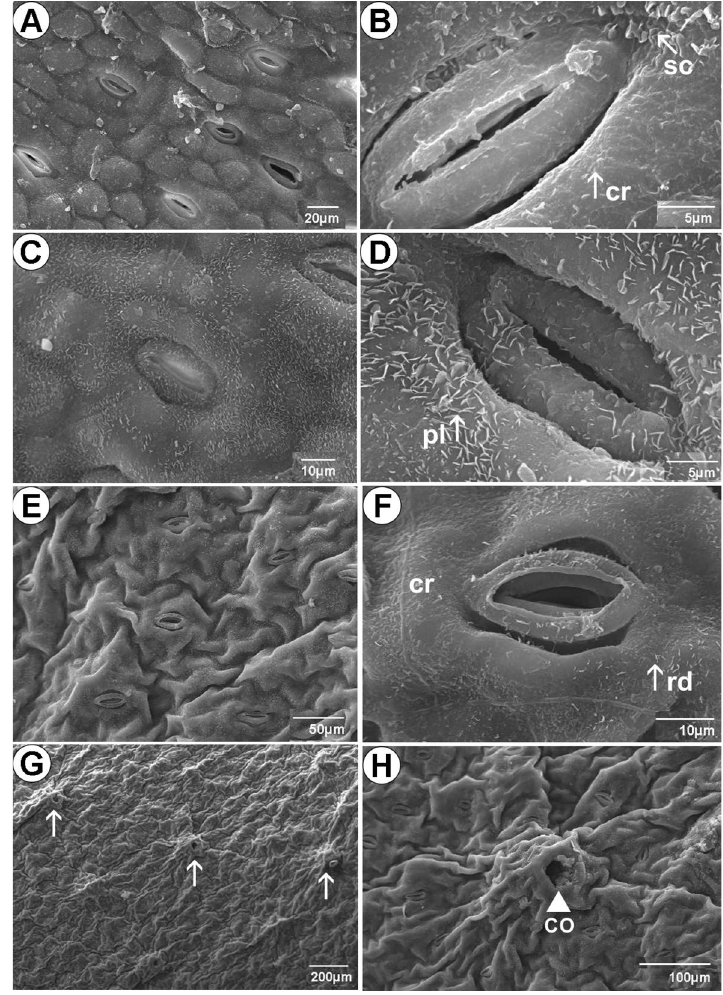
Figure 3. Leaf micromorphology of Laguncularia racemosa from three mangrove sites in Rio de Janeiro State (Brazil), showing different epicuticular wax deposition, stomata and pore of salt secretory structure located in a cavity by electronic microscopy. ( A , B ) Marambaia (M) mangrove: epicuticular wax layer in crusts (cr) and scales near a stomatal pore. ( C , D ) Pedra de Guaratiba (PG) mangrove: epicuticular wax in plates (pl) in all surfaces, including next to stomata. ( E – H ) Coroa Grande (CG) mangrove: epicuticular wax in crusts with some rodlets (rd) over ordinary epidermal cells and stoma. ( G , H ): abaxial epidermis from CG mangrove showing opening of epidermal cavity (co) where secretory multicellular glandular trichomes are located. ( A , C – H ) Abaxial surface. ( B ) Adaxial